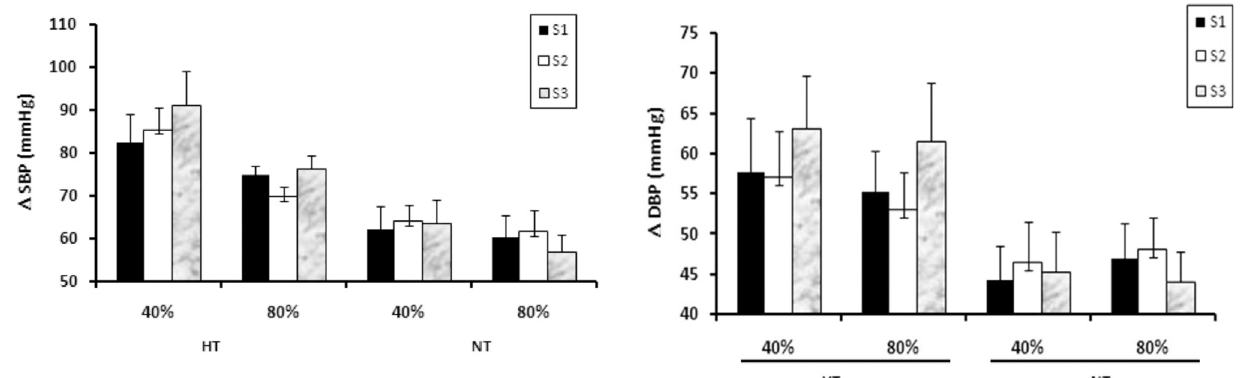
Figure 3 - Systolic blood pressure (SBP) responses, expressed as the value during a set minus the pre-exercise value ( D SBP), during each of three sets (S1, S2, and S3) of knee extension resistance exercises performed to exhaustion at 40% and 80% of 1RM (repetition maximum) in hypertensive (HT) and normotensive (NT) subjects. †, P<0.05 vs. normotensive subjects; ‡, P<0.05 vs. 80% of 1RM.